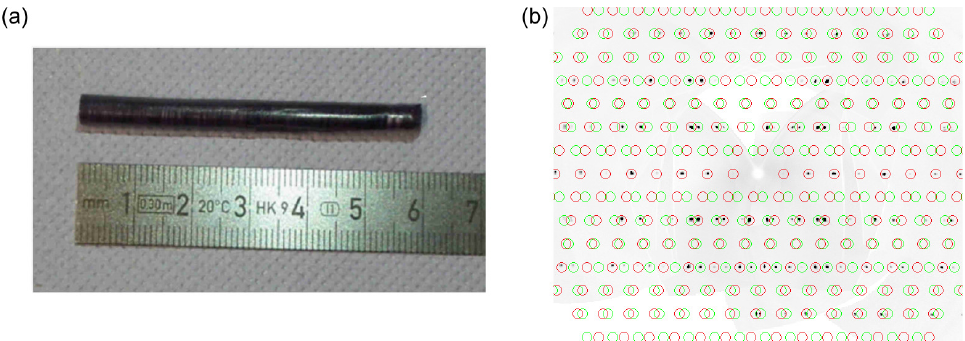
Figure 2. ( a ) Single crystal of CoGeO 3 grown in a high pressure mirror furnace; ( b ) intensities in the H 0 L plane of reciprocal space measured by means of single crystal X-ray diffraction, compare Table 1. These measurements reveal twinning in our single crystals with the twin law matrix ( − 1 0 − 0.732, 0 1 0, 0 0 1). The green and red circles indicate reflections belonging to twin domain A or B.